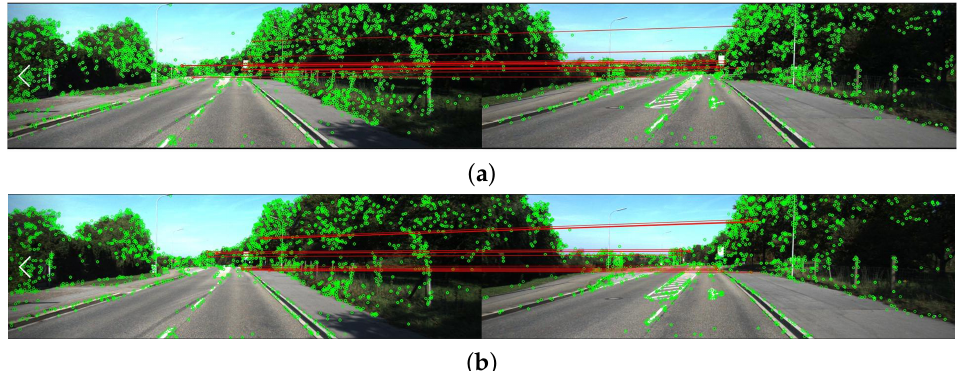
Figure 6. Matching results of the 17th group of pictures. ( a ) The matching results of the SIFT algorithm; ( b ) the matching results of the algorithm in this paper.